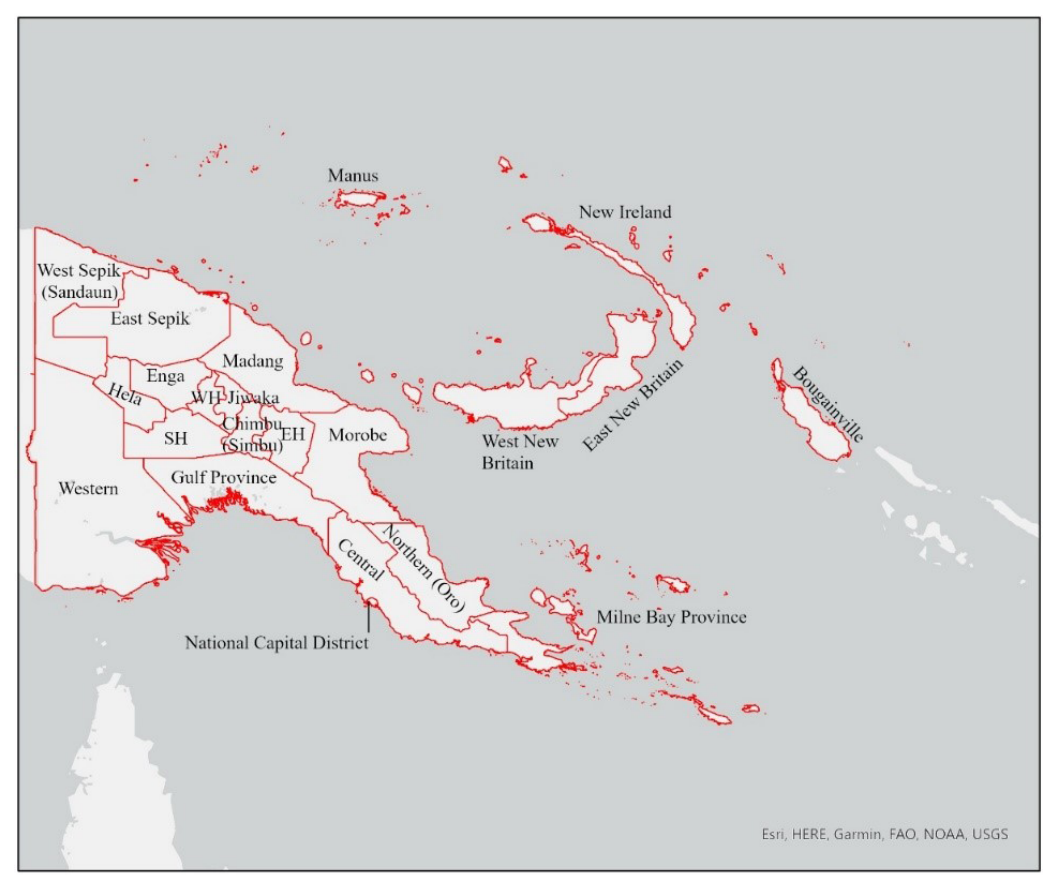
Figure 3. PNG map indicating each of the 22 PNG provinces with shortened names for Eastern Highlands (EH), Southern Highlands (SH), and Western Highlands (WH). Map was produced using ArcGIS Pro with an open-source base